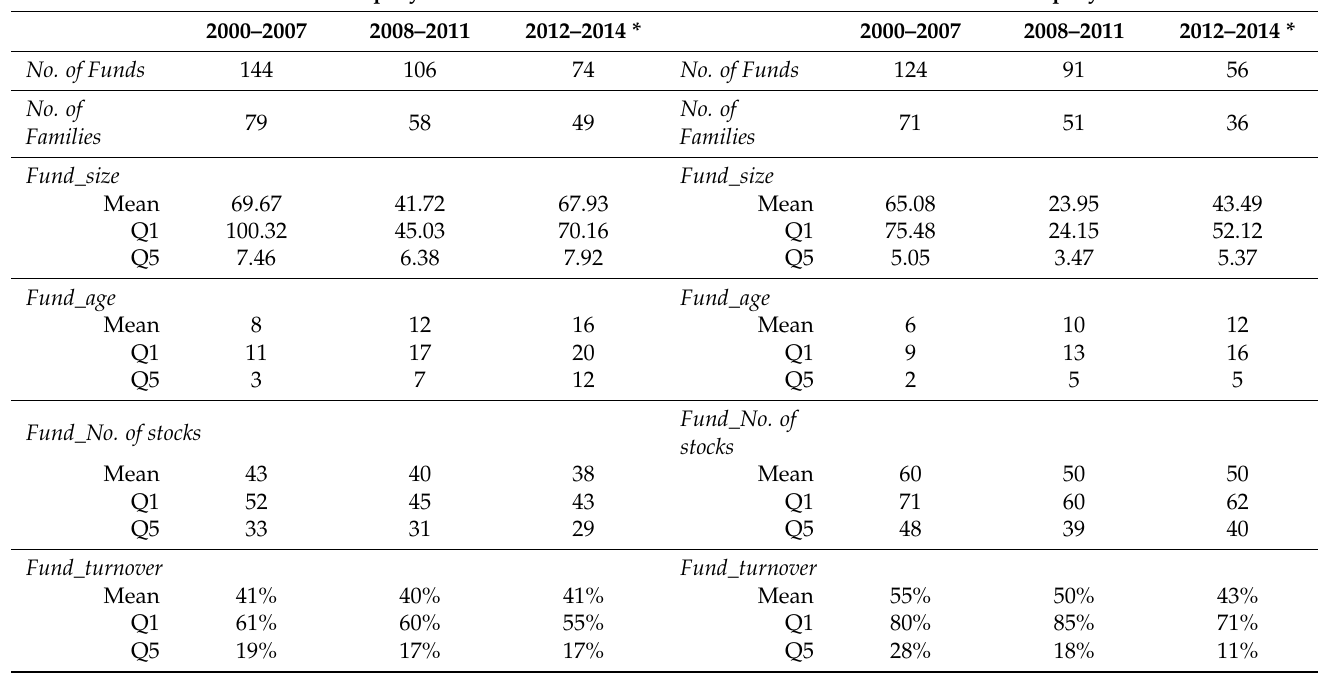
Table 1. Summary Statistics. This table presents the summary statistics of our comprehensive mutual fund sample. Panel A shows the average statistics for Euro domestic equity mutual funds. Panel B shows the same information for Euro non-domestic equity mutual funds. For simplicity, the sample period is split into three sub-periods: pre-crisis (2000–2007), crisis (2008–2011), and post-crisis (2012–2014). No. of Funds is the number of funds in our sample. No. of Families is the number of fund families in our sample. Fund_size is the monthly total net assets (TNA) of a fund in million euros. Fund_age is the age of a fund in years, we obtain the fund’s age from its inception date. Fund_No. of stocks is the number of distinct stocks in the monthly portfolio holdings. Fund_turnover is the fund’s annual turnover ratio. * The study period ends in March